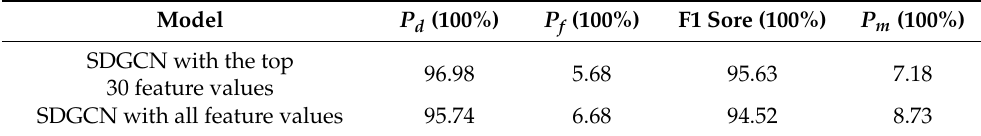
Table 3. Comparison of the top 30 feature values with all feature values.